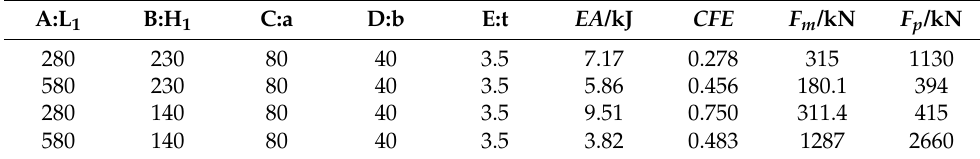
Table 3. Energy absorption and CFE under changing parameters L 1 and H 1